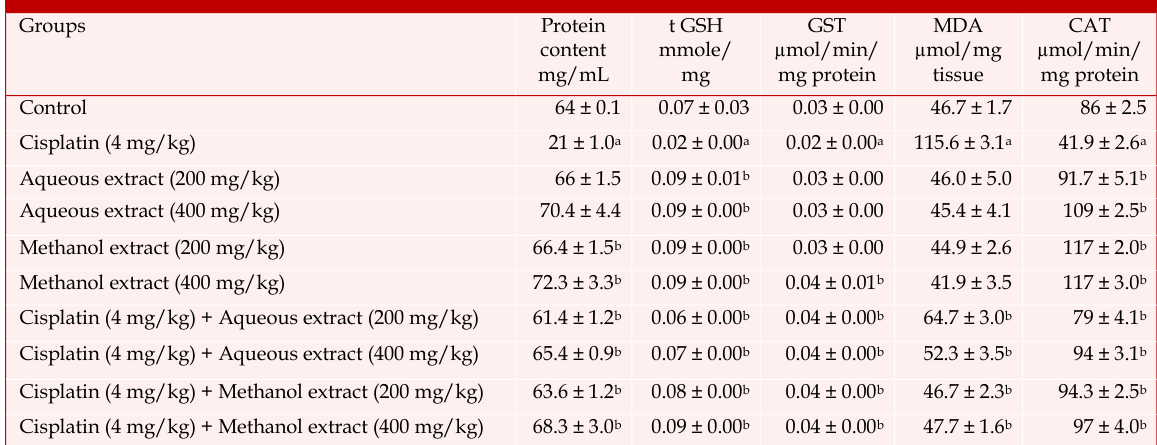
Effect of B. lyceum extract on protein content, GSH, GST, MDA and CAT in cisplatin-induced